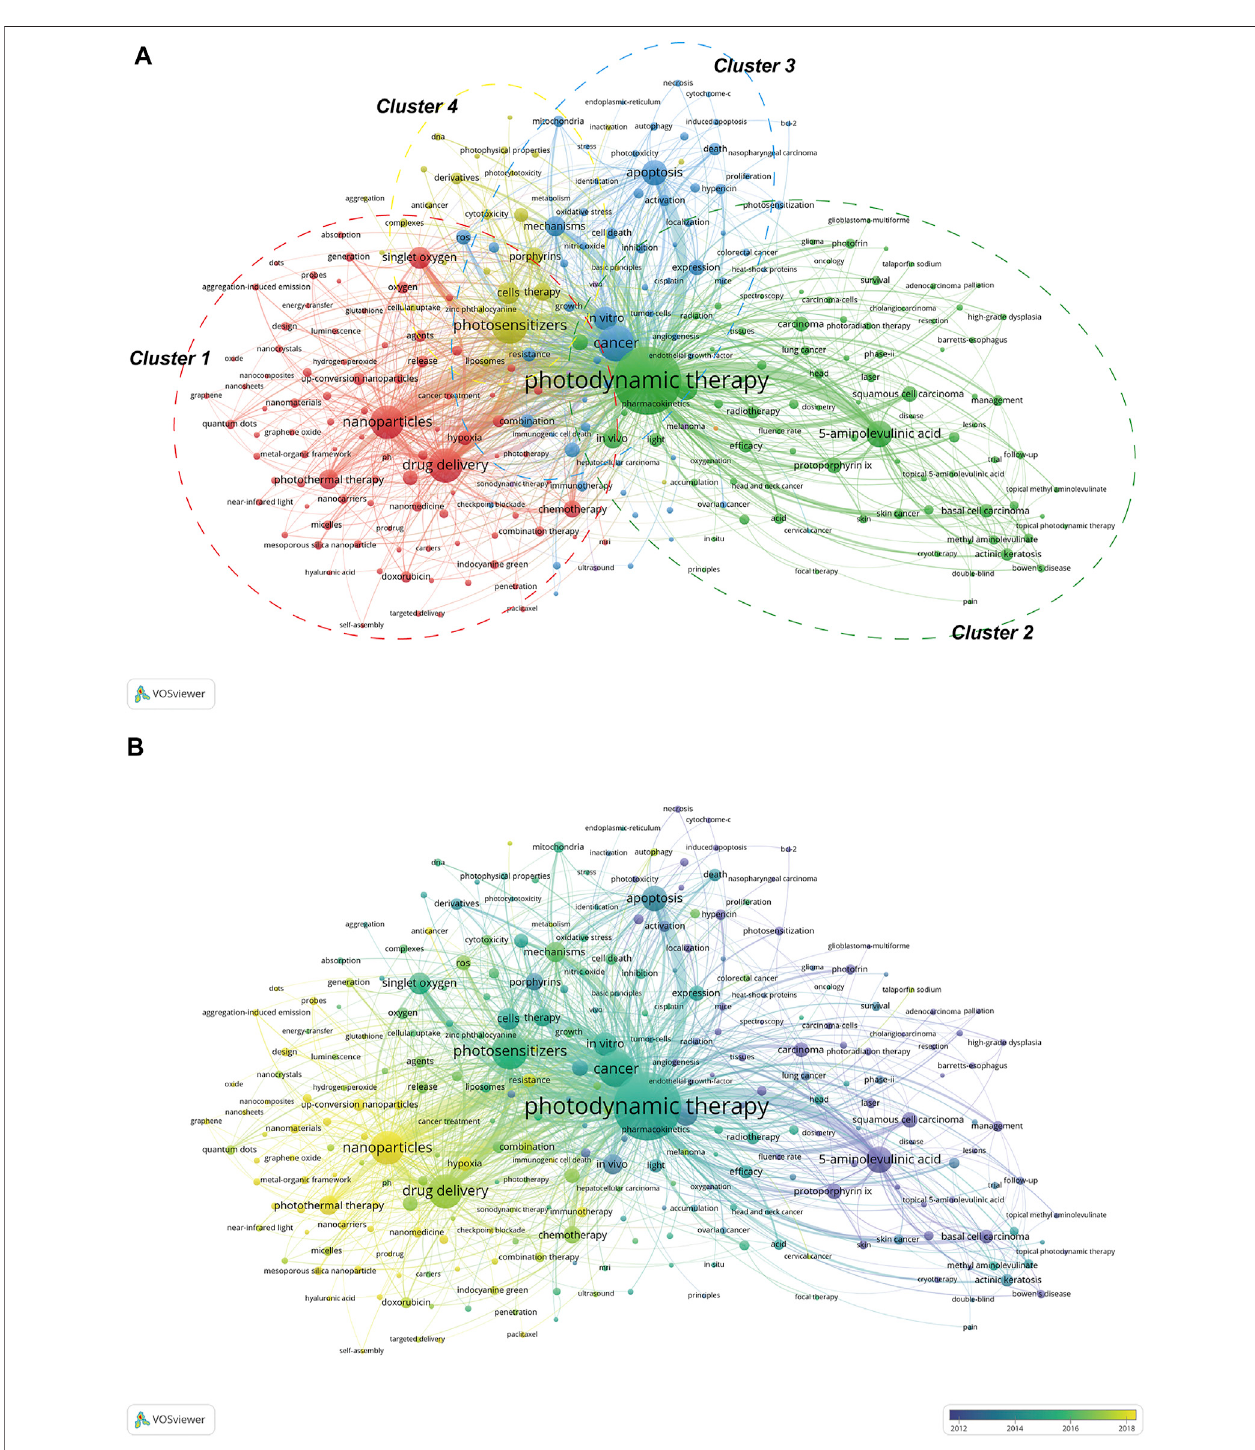
FIGURE 7 | (A) Network visualization map of keywords co-occurrence analysis. In this network map, keywords with close relationship are assigned to one cluster withthesamecolor.Allthekeywordscouldbedividedintofourclusters:cluster1(rednodes),cluster2(greennodes),cluster3(bluenodes),andcluster4(yellownodes). (B) overlay visualization map of keywords co-occurrence analysis. The node color re fl ects the corresponding AAY according to the color gradient in the lower right corner. The nodes marked with purple or blue color represent the keywords that appeared relativelyearlier, whereas keywords coded with yellowcolor represents the current research